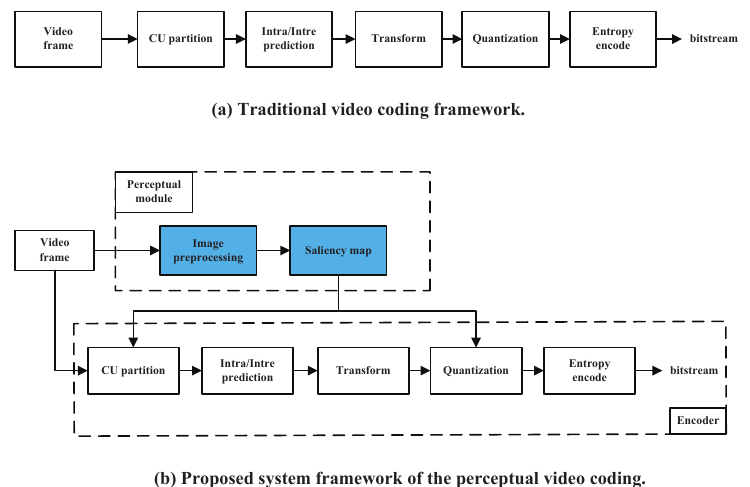
Figure 2. Traditional video coding framework and proposed perceptual video coding